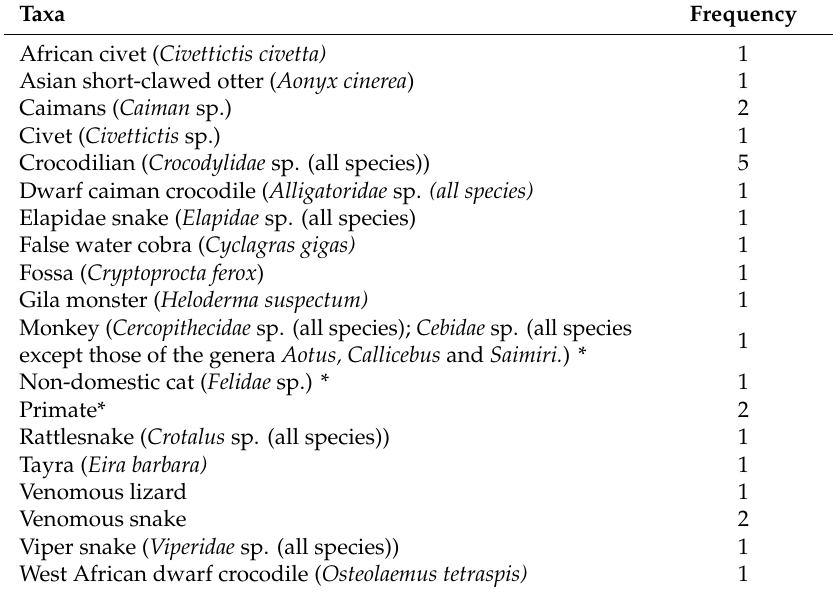
Table A4. Taxa listed on licences relevant to the Dangerous Wild Animals Act (1976). Frequency refers to the frequency of listings of descriptive terms relating to the specific